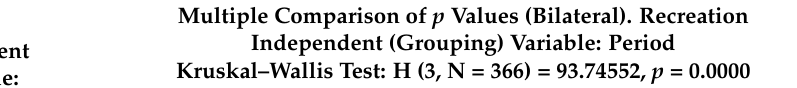
Table 3. Multiple comparisons of mean ranks of recreation activities for all pairs of groups (Period). p Values are two-sided significance levels with a Bonferroni adjustment.